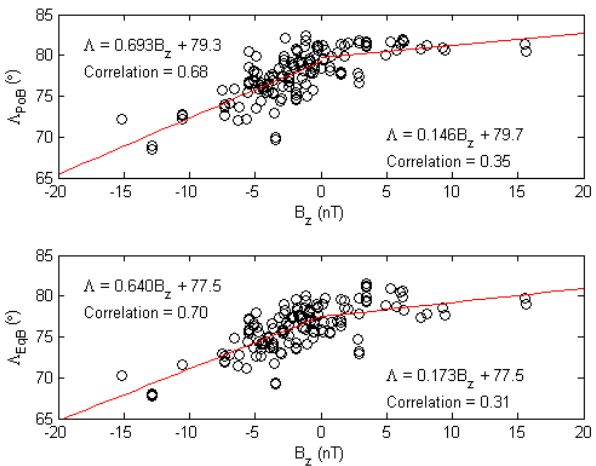
Fig. 10. Equatorward boundary of the cusp versus IMF- B z for the Northern (top) and Southern (bottom) Hemispheres. Filled circles correspond to B y dominated IMF. Only cases occurring under stable IMF conditions are plotted.